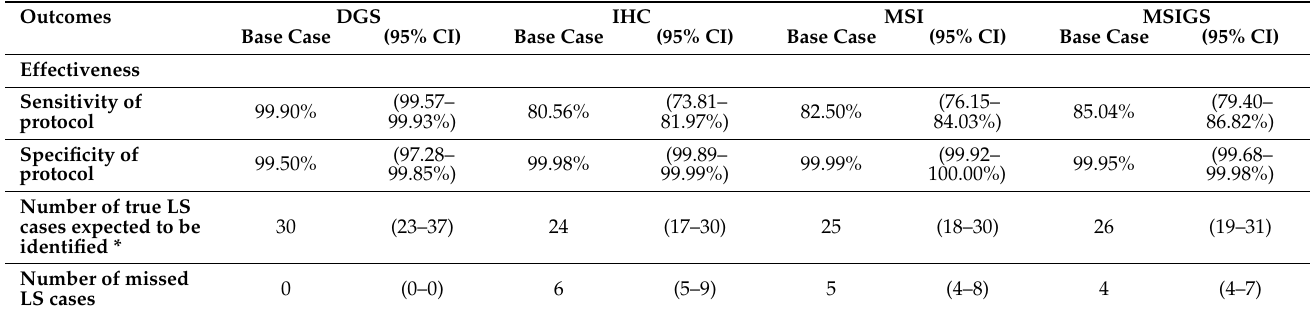
Table 1. Base-case and probabilistic sensitivity analysis on outcome